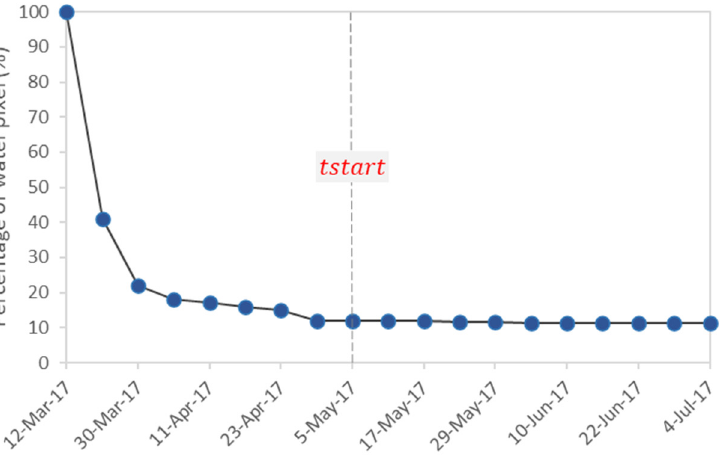
Figure 14. The percentage of water pixels in the initial surface water map on 12 March 2017 over time. The dashed line in gray color (5 May 2017) presents the actual starting time ( 𝑡𝑠𝑡𝑎𝑟𝑡 ) for the flood monitoring algorithm.